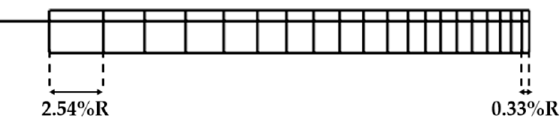
Figure 5. Modified VR-12 airfoil with a tab [25].